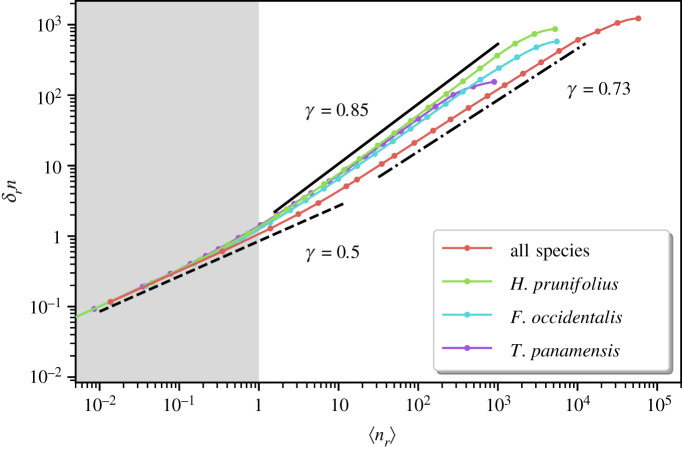
Spatial density fluctuations: standard deviation of number of trees, δrn=[⟨nr2⟩−⟨nr⟩2]1/2, as a function of the mean number of trees, 〈nr〉. Borders are identified via α-shapes, and bias is cured as described in the text. Lines display Taylor’s Law exponents γ = 1/2 (dashed, corresponding to a homogeneous random process), γ ≈ 0.85 (solid, the value that describes the labelled species with some variability of the order of 0.03) and γ ≈ 0.73 (dot dashed, describing the community behaviour).